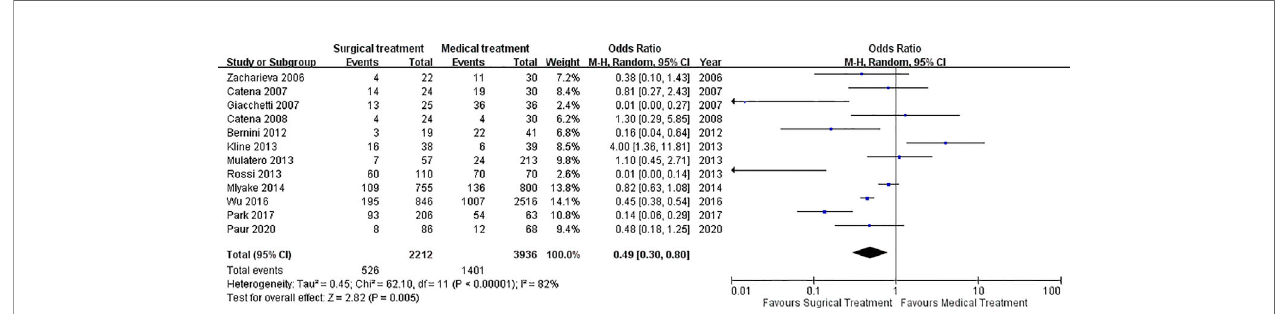
FIGURE 3 | Forest plot of the OR of primary outcome. Forest plot of the OR of primary outcome (composite outcomes) in patients with primary aldosteronism under medical treatment or surgical treatment. Central squares of each horizontal line represent the OR for each study. Horizontal lines indicate the range of the 95% CI and the vertical line indicates an OR of 1.0 (which indicates no differences in the odds ratio between medical treatment or surgical treatment). OR, odds ratio.